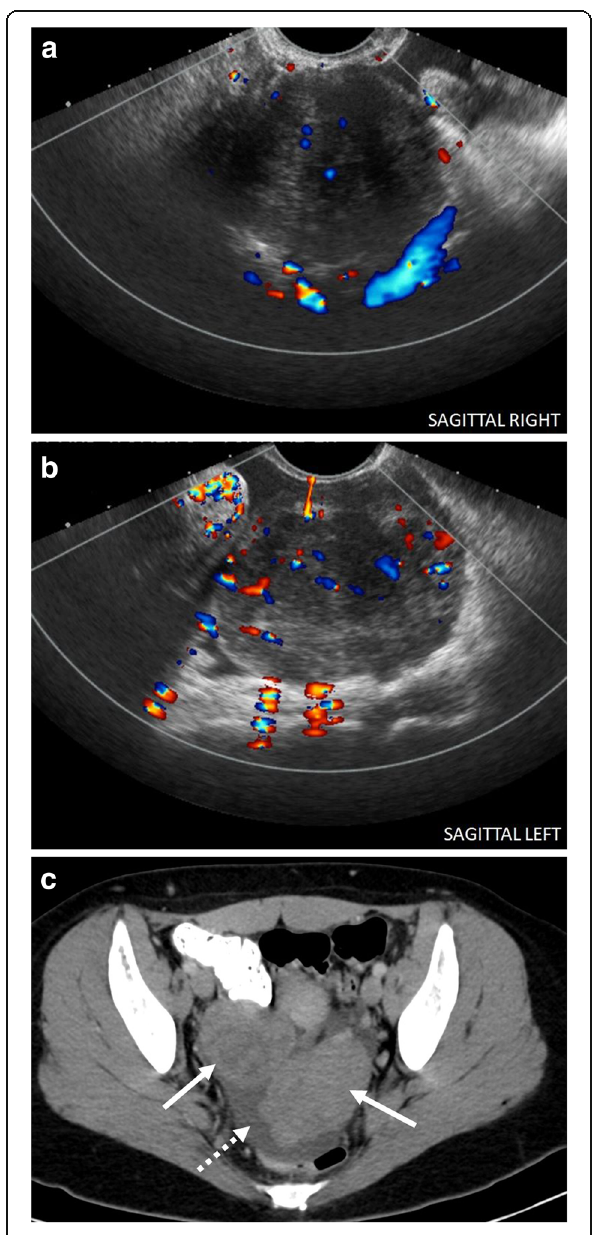
Fig. 7 Bilateral ovarian masses. A 23-year-old female presenting with pelvic pain. Sagittal color Doppler images through the ( a ) right and ( b ) left ovaries demonstrate heterogeneous enlargement of the bilateral ovaries containing internal flow, greater on the left. c Subsequent contrast-enhanced CT shows markedly enlarged bilateral ovaries (solid arrows) with adjacent pelvic free fluid (dashed arrow). Subsequent exploratory laparotomy with bilateral salpingo-oophorectomy revealed Burkitt